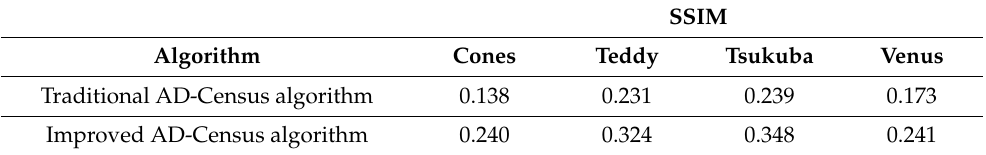
Table 4. Comparison of algorithms’ SSIM.